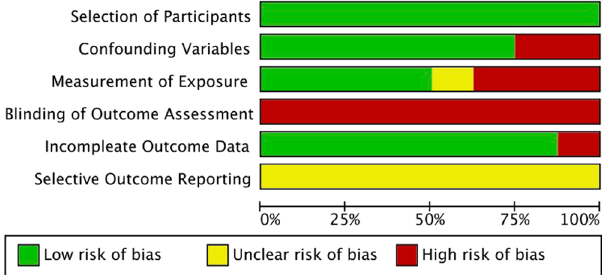
Figure 2. Risk of bias graph review authors’ judgements about each risk of bias item presented as percentages across all included studies.